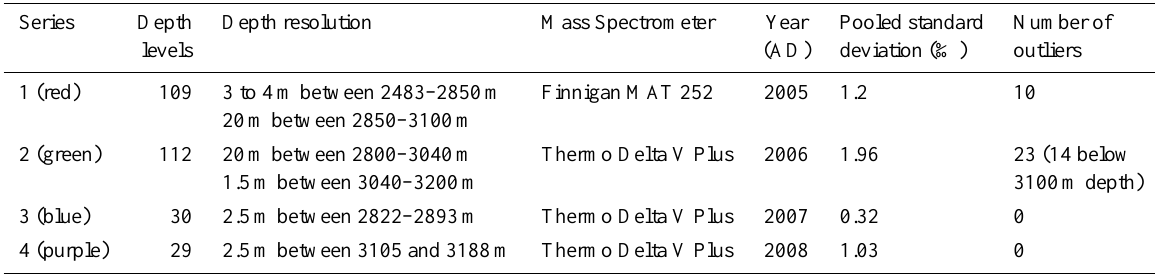
Figure 1 Measurements of δ O 2 /N 2 in the EPICA Dome C (EDC) ice core plotted on the EDC3 ice core age scale [Parrenin et al, 2007] and associated uncertainty (1 σ , bottom). The EDC δ O 2 /N 2 record is composed of four distinct measurement series (top). Samples measured in series 1 and 2 were stored at -25°C whereas samples measured in series 3 and 4 were stored at -50°C. Characteristics of the different series are given in Table 1: Series 1 in red, Series 2 in green, Series 3 in blue, Series 4 in purple.